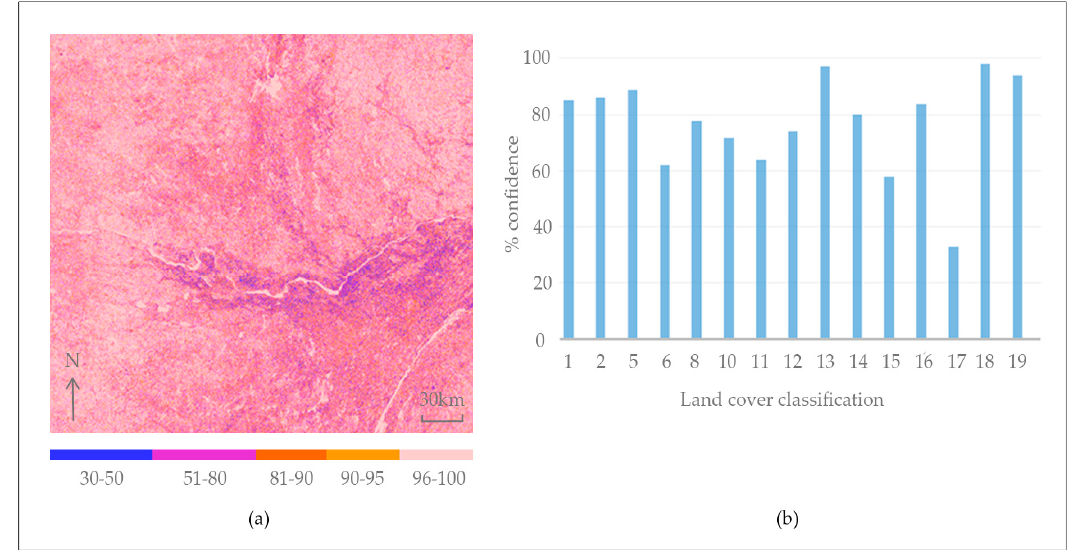
Figure 6. ( a ) Example of classifier confidence i.e., posterior probability based on voting the random forest trees; ( b ) average confidence by land cover type.